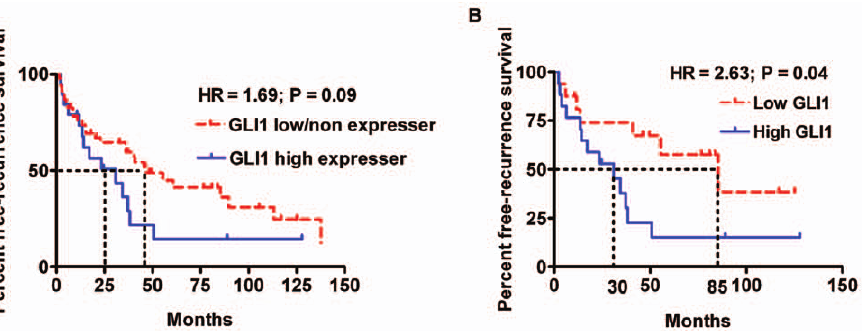
Figure 2. GLI1 expression is positively associated with HCC recurrence. (A) Tumor recurrence after surgical resection in 139 patients with HCCs. Differences between the Kaplan-Meier curves of patients in the GLI1 high expresser group and those in GLI1 low/non expresser group using the log rank test. (B) Tumor recurrence after surgical resection in the 35 patients from the high GLI1 group and in the 35 patients from the low GLI1 group. Increased GLI1 expression in HCC tissues was significantly correlated with more rapid tumor recurrence after surgical resection of the primary tumor.